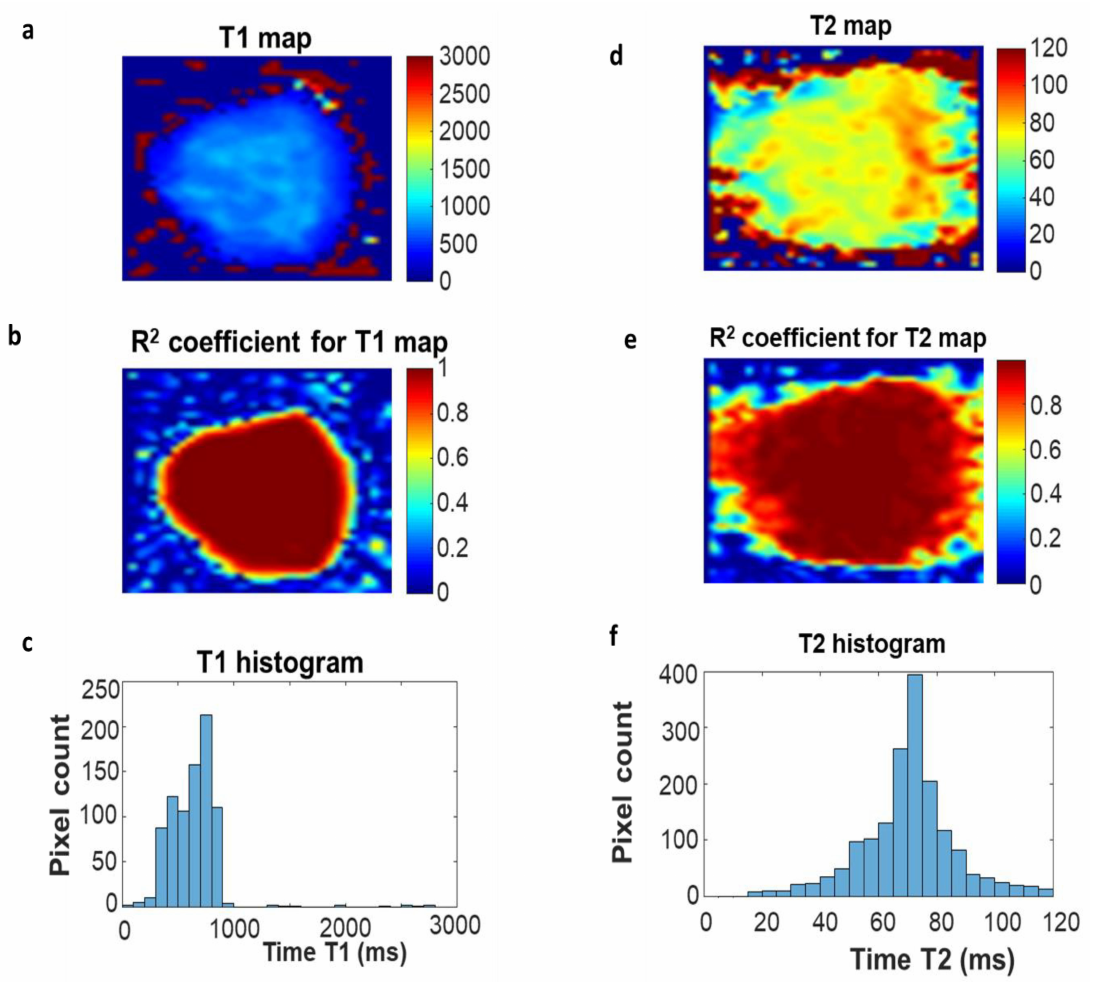
Figure 8. Selection of the area of interest for the measured samples: ( a ) distribution of the longitudinal relaxation time T 1 in the prostate tissue section before PDT; ( b ) distribution of the R 2 fit factor; ( c ) a histogram of the values of T 1 times determined from image ( a ); ( d ) distribution of transverse relaxation time T 2 values in a segment of the diseased tissue before PDT; ( e ) distribution of the R 2 fit factor; ( f ) a histogram of the values of T 2 times determined from the image ( d